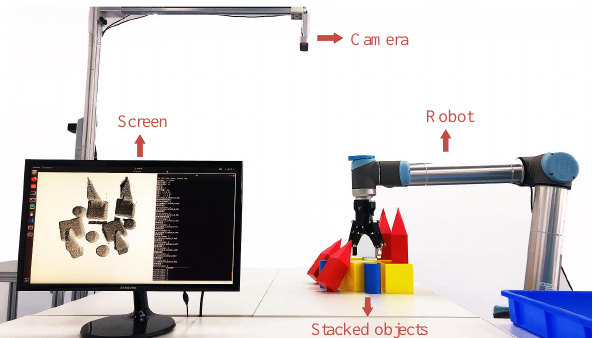
Figure 7. Grasping Experimental System. An Azure Kinect DK camera is employed to obtain the image. A UR-10 robot is employed to grasp the stacked